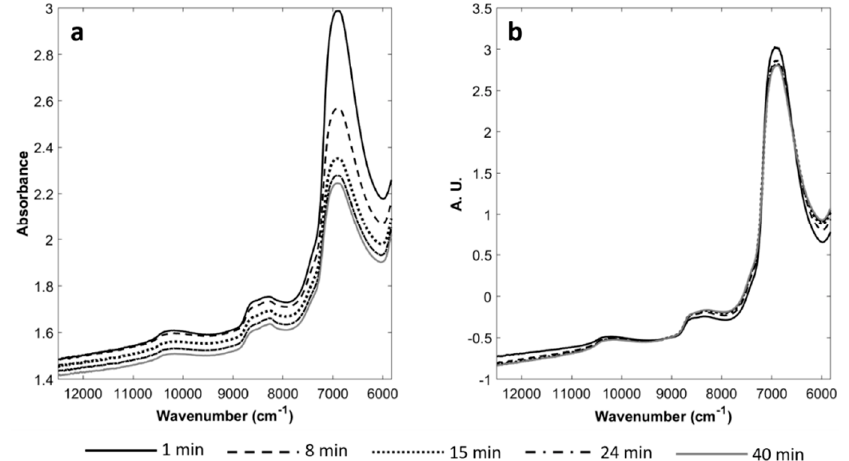
Figure 1. FT-NIR spectra collected for one milk renneting batch developed under normal operating conditions (NOC 13a ): temperature, 35 ◦ C; milk pH, 6.5; fat content, 2.55 g / 100 mL. ( a ) raw spectra; ( b ) Standard Normal Variate (SNV) pre-treated spectra.